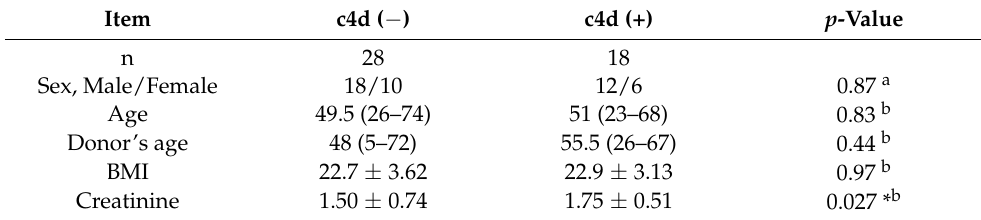
Table A2. Characteristics of participants with c4d (+) and c4d ( − ).